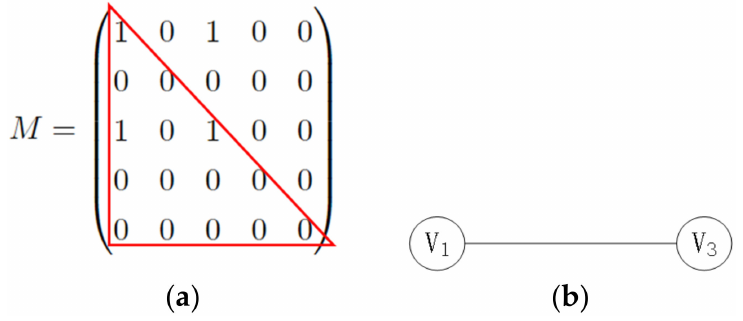
Figure 4. ( a ) matrix M ; ( b ) Intersection graph of G 1 , G 2 , G 3 , G 4